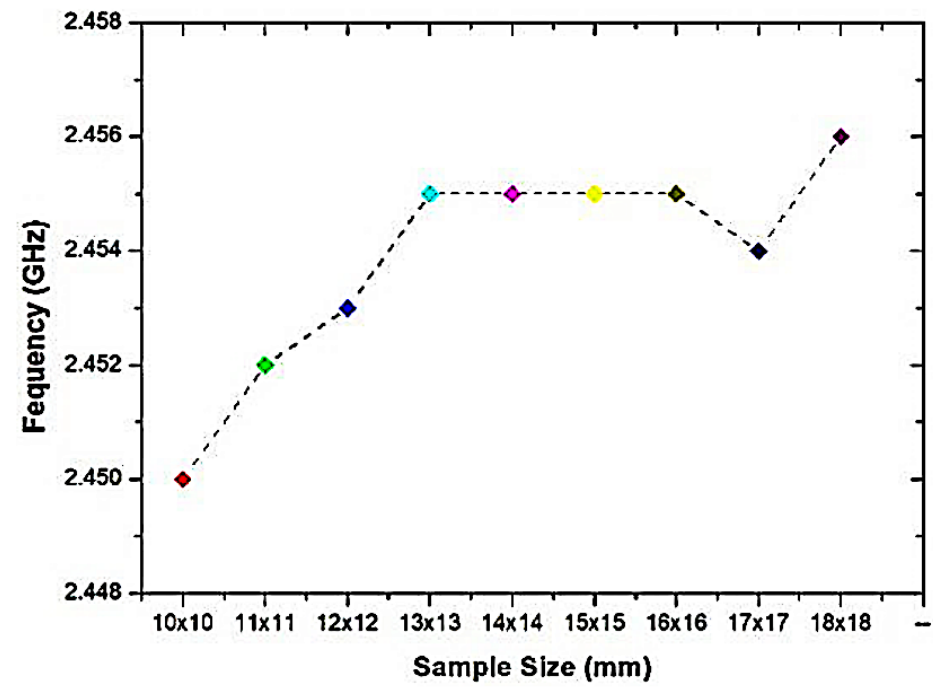
Figure 8. Relationship between frequencies with specimen dimensions of (l × w) mm .